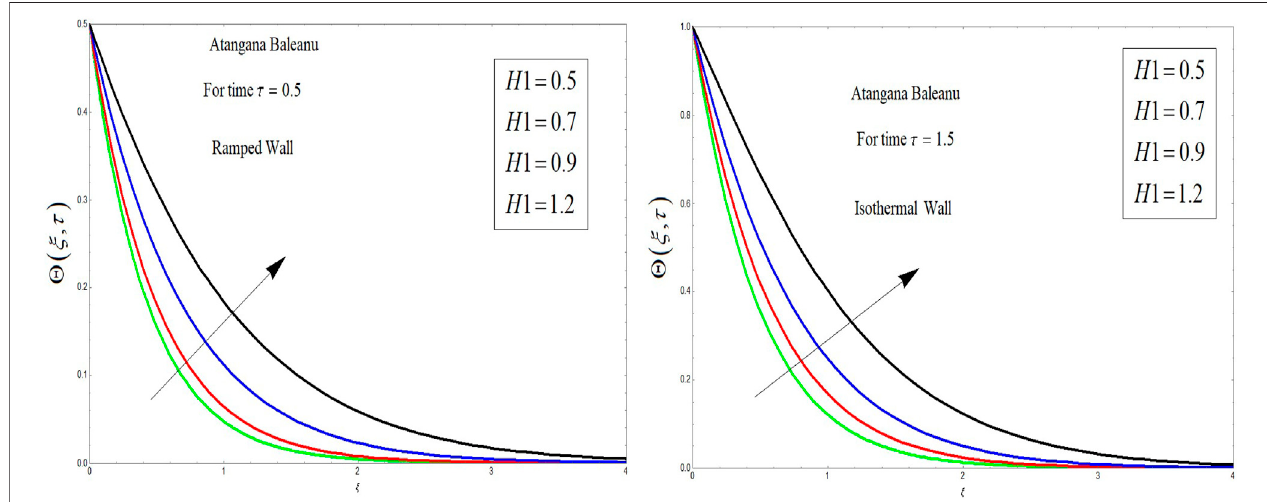
FIGURE 11 | Impact of H1 on temperature (AB fractional